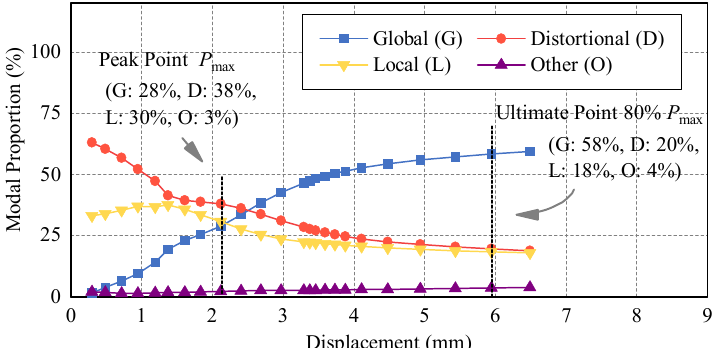
Figure 6. Full range modal participation of member FE simulation (member cross-section parame- ter is No. 1, 2 mm thick, 300 mm long).